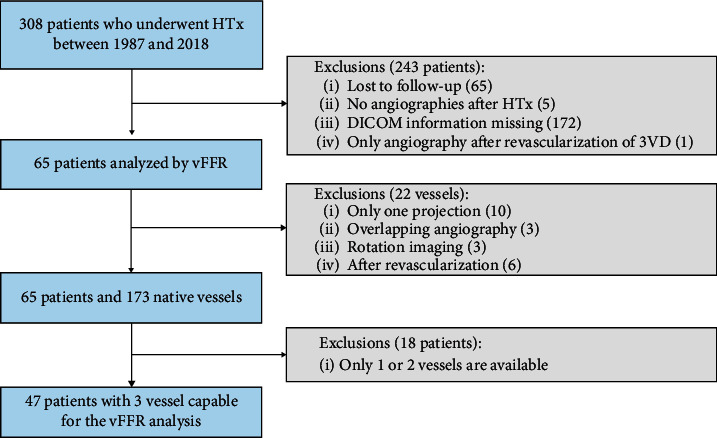
A total number of 65 patients who underwent heart transplant and in whom one or more vessels could be analyzed using vFFR were included. Subsequently, the vFFR value of all three native coronary arteries and the ISHLT CAV grade were compared. HTx, heart transplantation; vFFR, vessel fractional flow reserve; ISHLT, international society of heart and lung transplantation; and CAV, cardiac allograft vasculopathy.